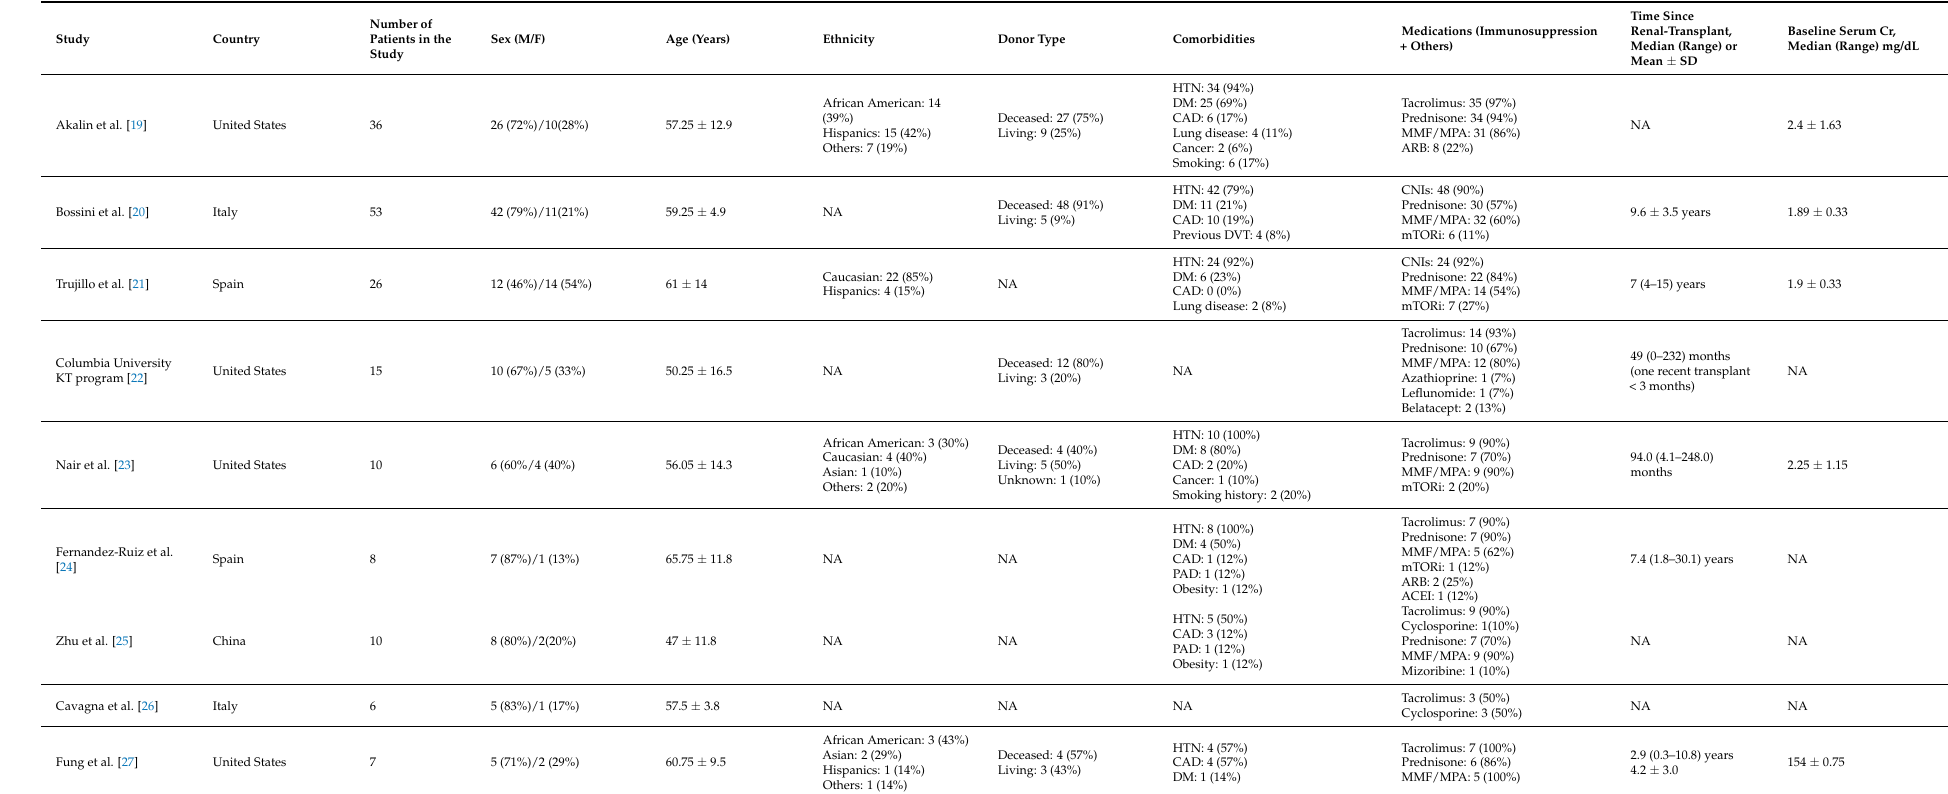
Table A1. Baseline demographic and clinical data of post-kidney transplant COVID-19 patients in a sequence of publication